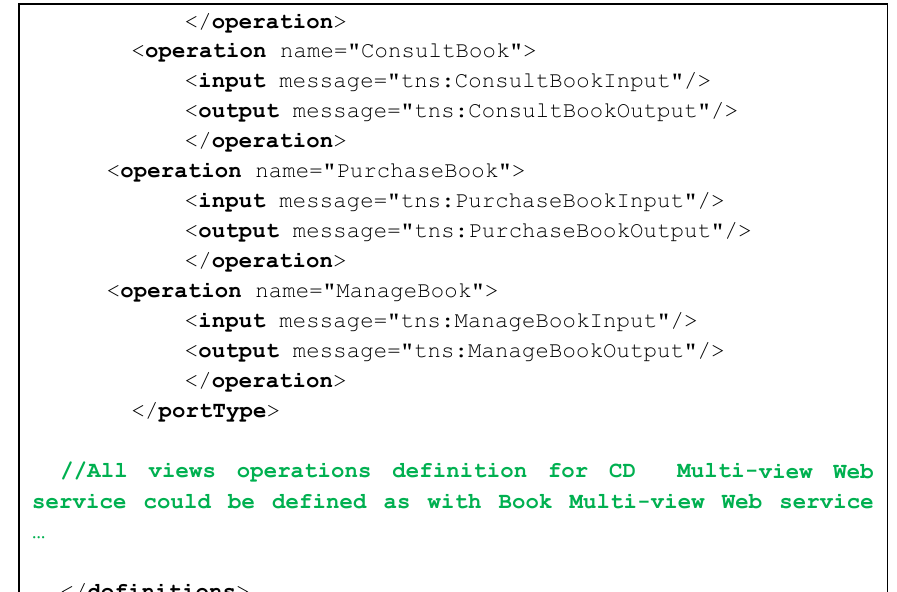
Fig. 7. The generated standard WSDL definition of Multi-view Web services of the Online Library study